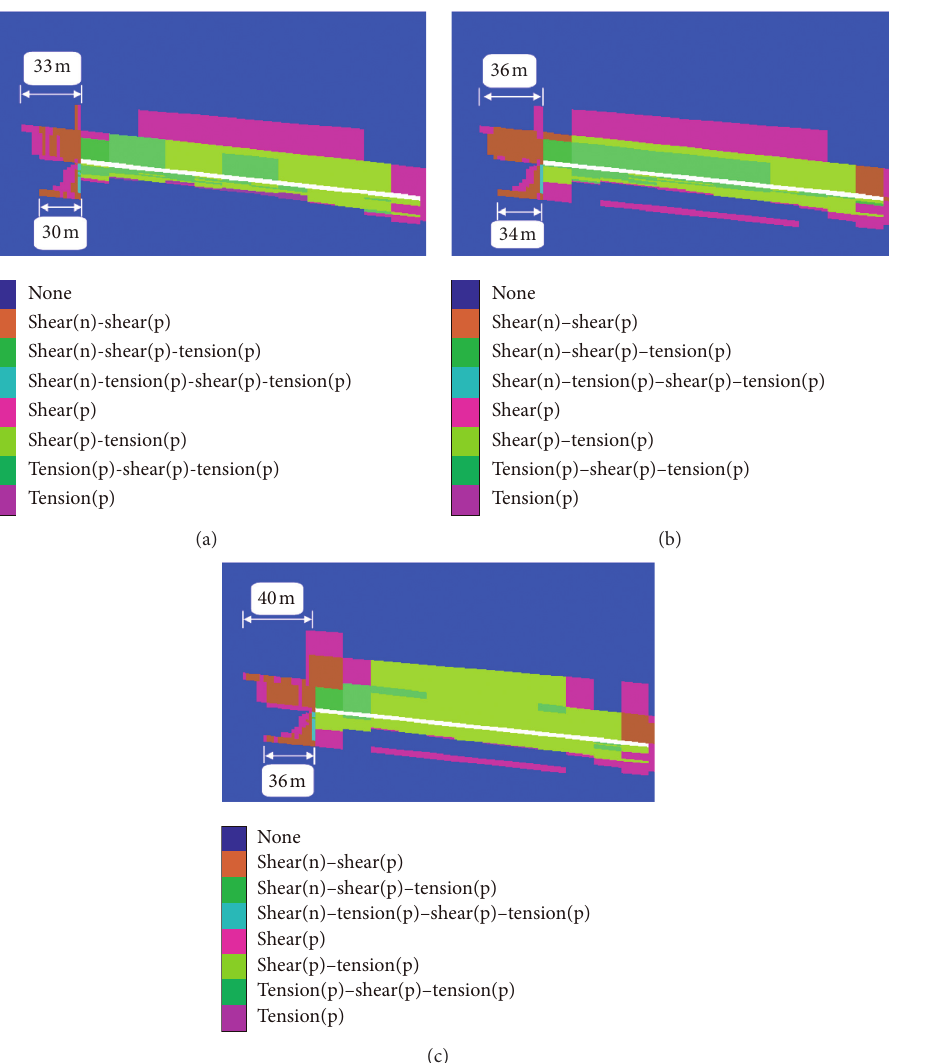
Figure 8: Distribution of plastic zone of surrounding rock at different advancing distance of working face. (a) Advancing 100m, (b) advancing 140 m, and (c) advancing